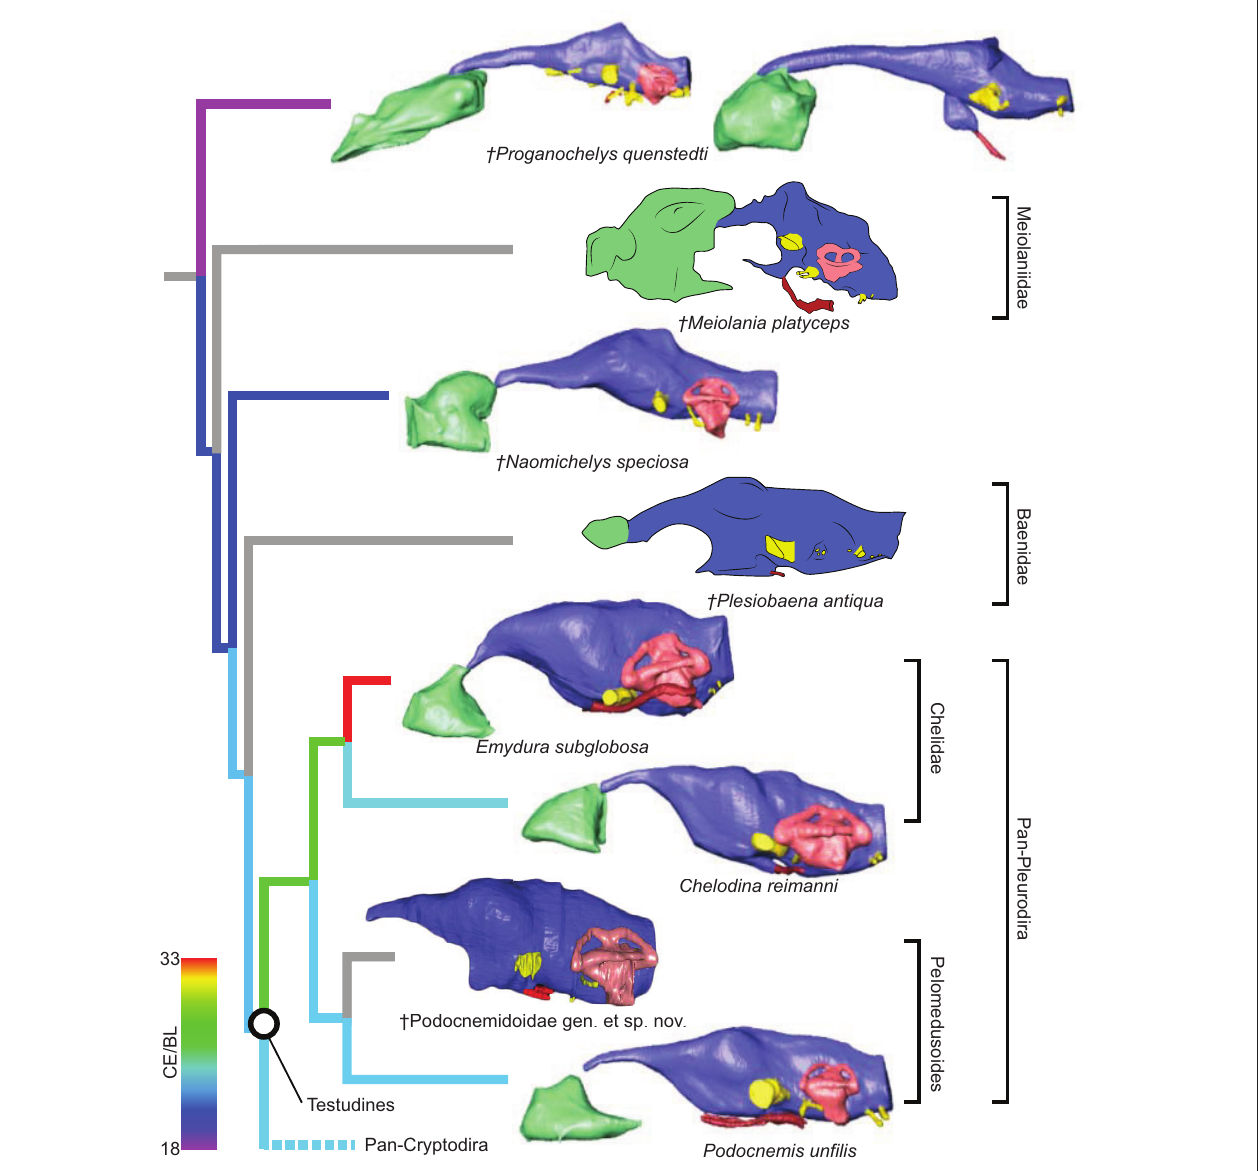
FIGURE 2 | Comparative endocranial anatomy of different stem-Testudines and pleurodiran taxa. Original reconstructions and redrawn endocasts ( Plesiobaena antiqua from Gaffney, 1982; Meiolania platyceps from Paulina-Carabajal et al., 2017; Podocnemidoidae sp. et gen. nov. from Ferreira et al., 2018) in left lateral view. Topology based on Joyce et al. (2016), Guillon et al. (2012), and Ferreira et al. (2018). Heat mapping on branches based on the ratio (CE/BL) between cubic root of endocast volume and basicranial length ( Table 1